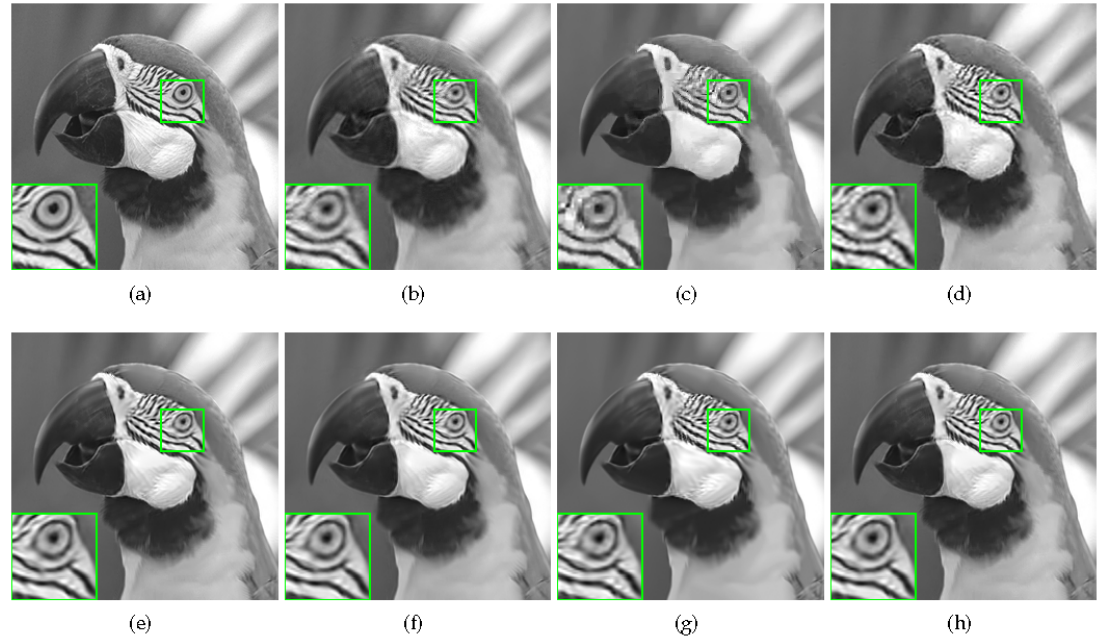
Figure 6. Reconstruction of Parrots with sampling rate = 0.2. ( a ) Original image; ( b ) MH (PSNR = 29.23 dB, FSIM = 0.9405); ( c ) RCoS (PSNR = 28.61 dB, FSIM = 0.9311); ( d ) ALSB (PSNR = 29.73 dB, FSIM = 0.9460); ( e ) GSR (PSNR = 31.17 dB, FSIM = 0.9524); ( f ) JASR (PSNR = 31.09 dB, FSIM = 0.9478); ( g ) GSR-NCR(PSNR = 30.18 dB, FSIM = 0.9435); ( h ) Proposed HNLSR (PSNR = 31.41 dB, FSIM = 0.9526 )).